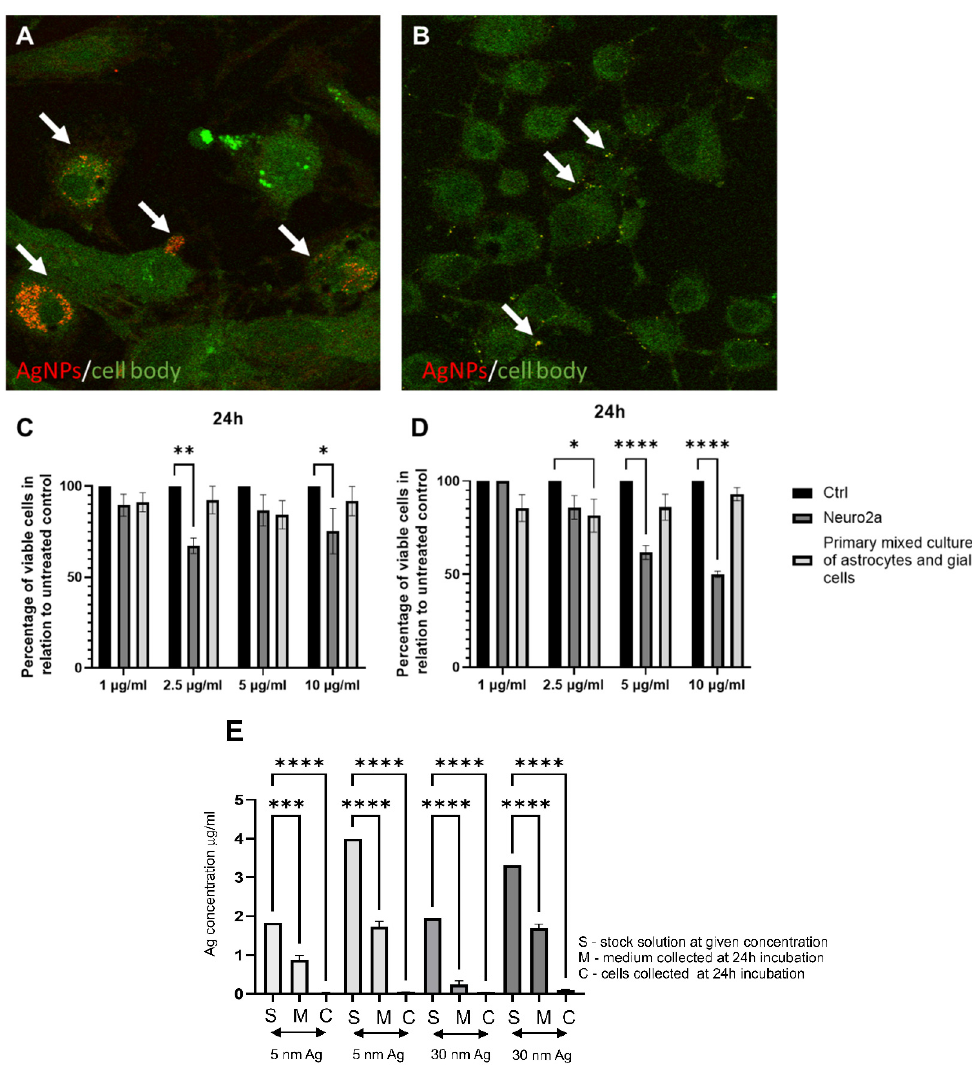
Figure 4. AgNPs internalization by confocal microscopy, ICP-MS and size/cell type-dependent toxicity. Primary mixed culture of astrocytes and glial cells ( A ), forskolin differentiated Neuro-2a